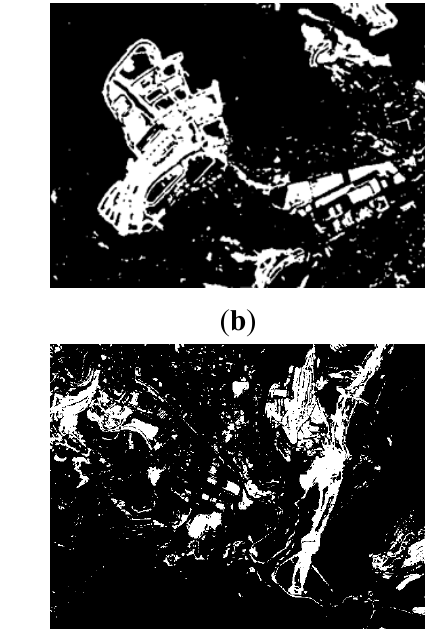
Figure 10. Level 2. Change detection documents ( λ method-area 1; ( b ) Multiplicative method–area 1; ( c ) Summative method-area 2; ( d ) Multiplicative method-area 2.